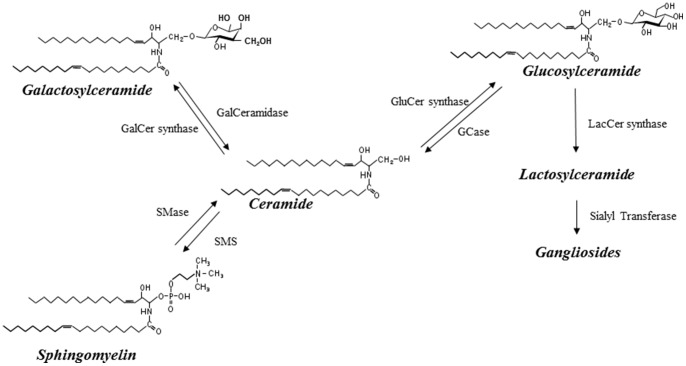
Ceramide and glycolipid metabolism.Products are indicated in bold and italics. Abbreviations for enzymes are as follows: GCase: glucocerebrosidase; GalCer synthase: galactosylceramide synthase; GluCer synthase: glucosylceramide synthase; GalCeramidase: galactosyl ceramidase; LacCer synthase: Lactosylceramide synthase; SMase: Sphingomyelinase; SMS: Sphingomyelin synthase.